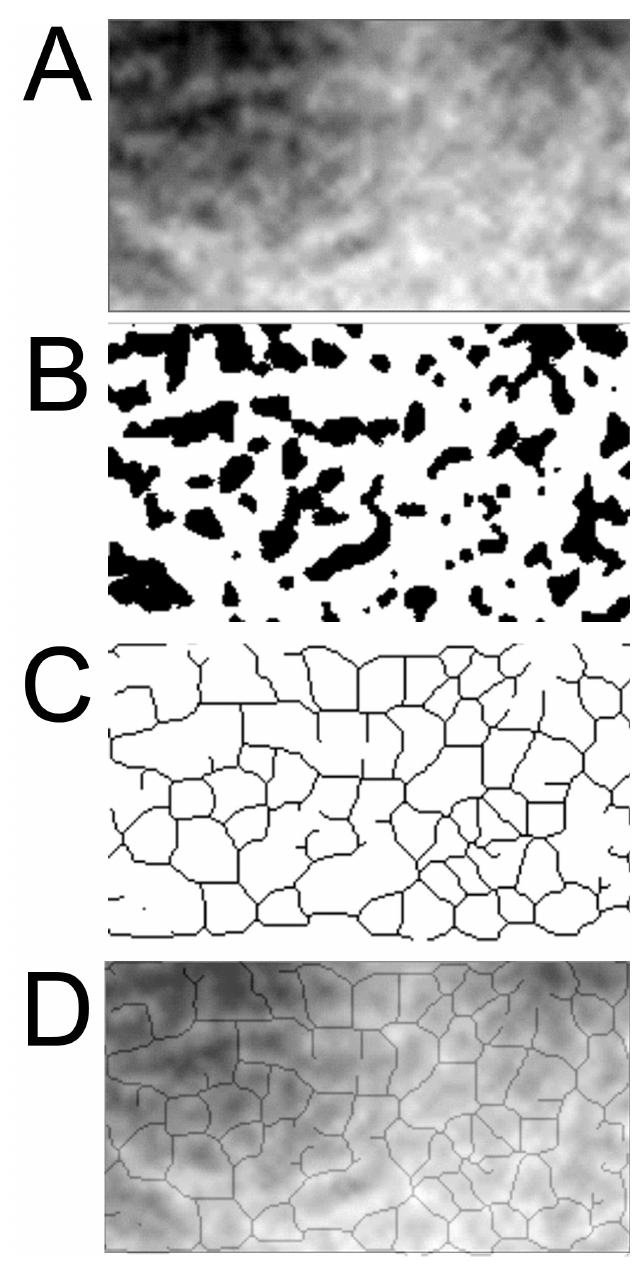
Fig.1. Methodology used to assess FD on panoramic radiographic images. A) Optimized panoramic radiographic image B) Conversion to binary image C) Skeletonized image D) Skeletonized image projected over the regular optimized panoramic radiographic